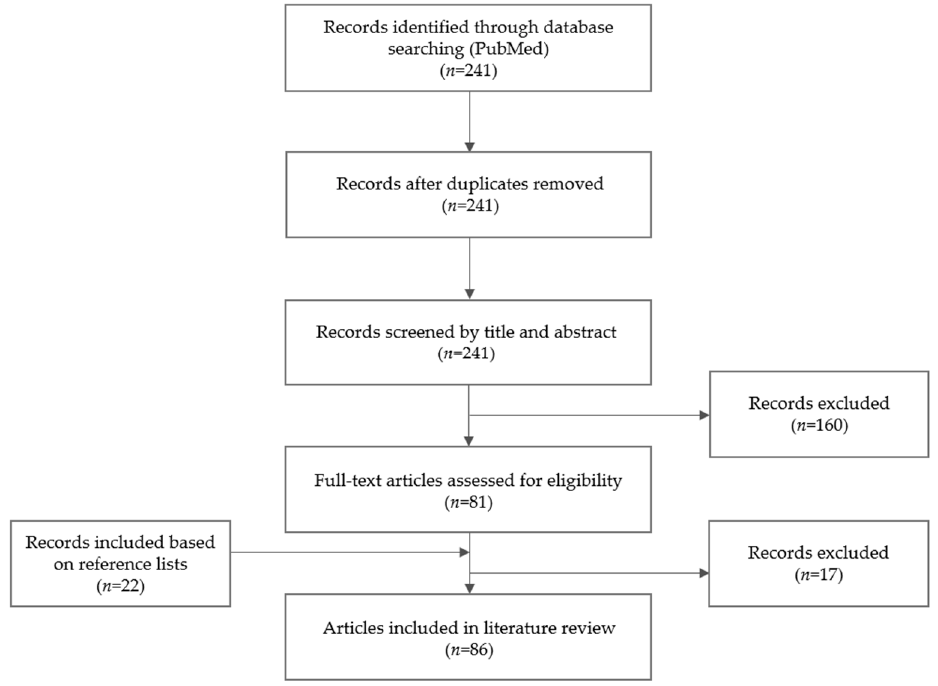
Figure 2. Selection process of articles on the antifungal treatment of Aspergillus osteomyelitis. A total number of 108 Aspergillus osteomyelitis or spondylodiscitis cases wasidentified, including FRI ( n = 6; 5.6%), rib/sternal osteomyelitis ( n = 21; 19.4%), osteomyelitis of the lower extremities ( n = 9; 8.3%), vertebral osteomyelitis ( n = 39; 36.1%) and spondylodiscitis ( n = 33; 30.6%). Demographic, clinical and therapeutic characteristics of Aspergillus